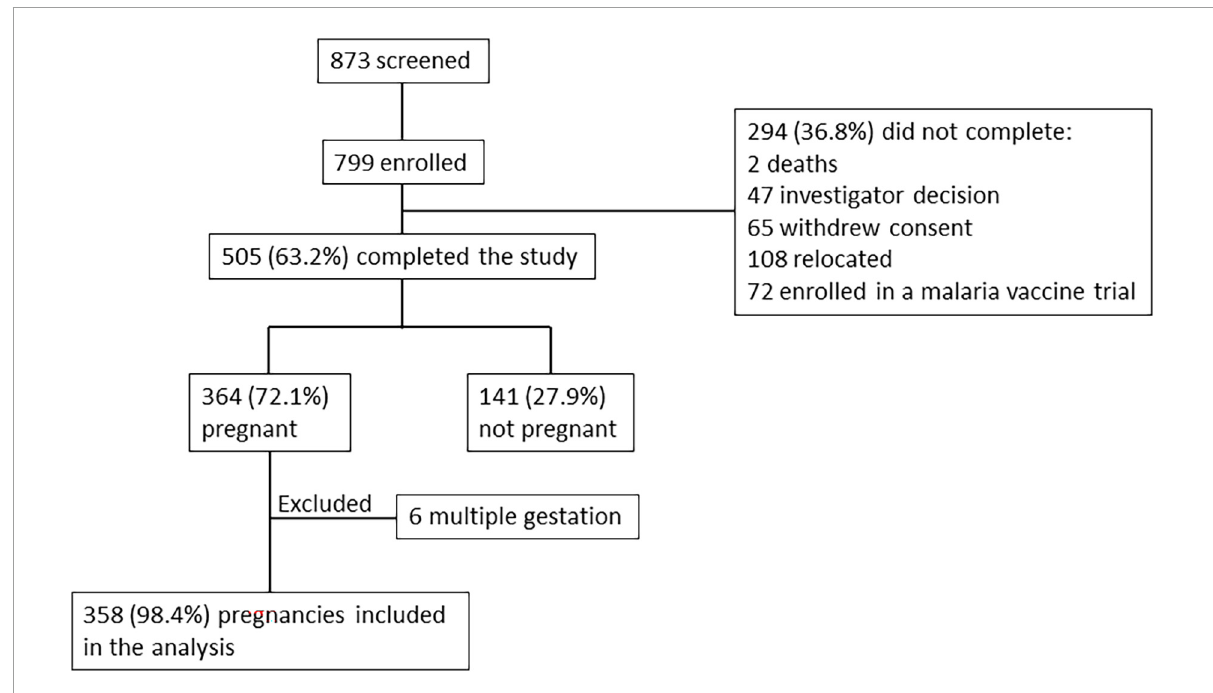
FIGURE1 Flow chart of study